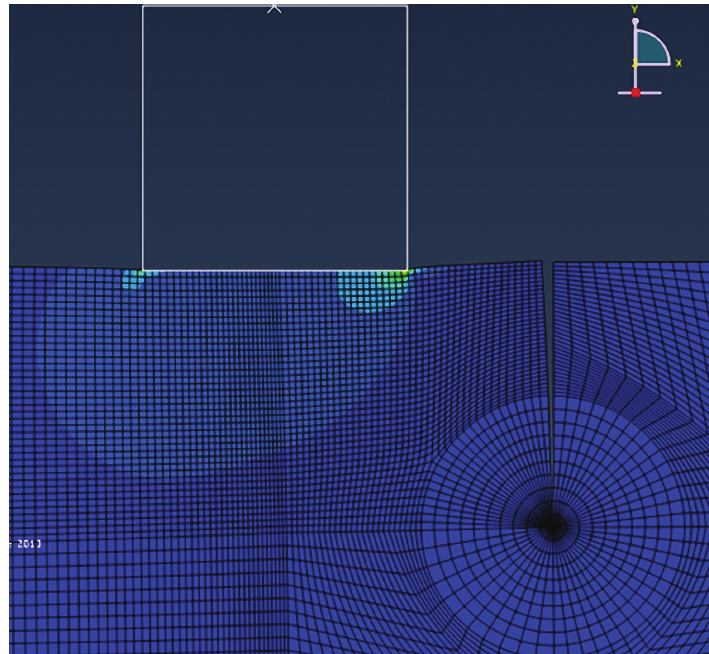
Figure 3. The Deformed shape and opening crack of the finite element mesh.